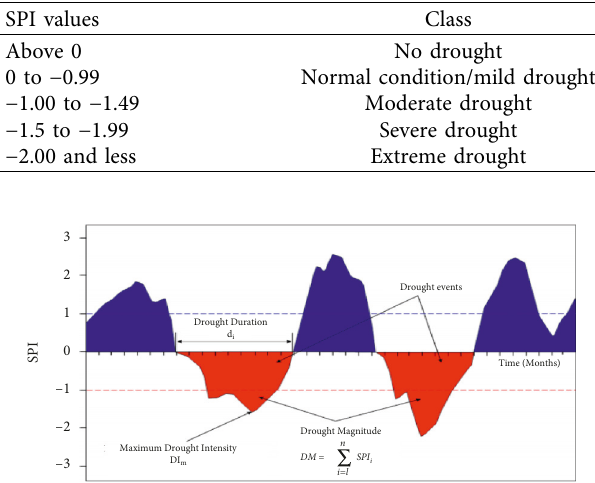
Figure 2: Definition of drought characteristics based on the SPI index (blue dashed line shows one standard deviation wetter than average, and while the red dashed line shows one standard devi- ation drier than average (Source: